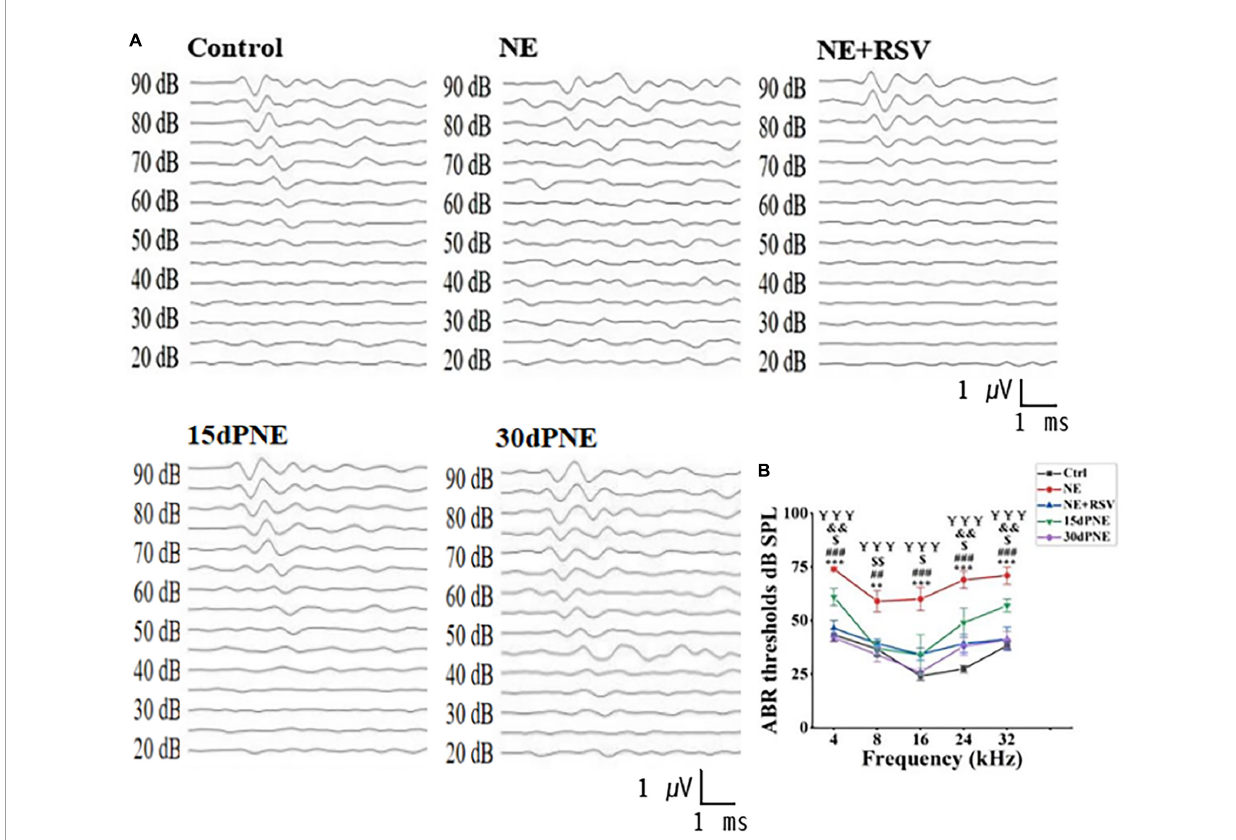
FIGURE2 ABR tests show that noise exposure increased reversibly hearing thresholds, and resveratrol treatment prevented hearing thresholds. (A) Example waveforms from a control mouse (Ctrl), noise exposure mouse (NE), resveratrol treatment mouse (NE + RSV), a mouse 15 days after noise exposure (15dPNE), and a mouse 30 days following noise exposure (30dPNE). (B) The averaged hearing threshold of each group is shown. Compared with the Ctrl group, the hearing threshold of mice in the NE group was significantly increased; the hearing threshold of mice in the NE + RSV group was significantly lower than that of the NE group; improved hearing thresholds were observed in 15dPNE and 30dPNE groups. Values are mean ± SE, data was analyzed by Tukey’s test following one-way of ANOVA. Each group consisted of 7 mice. Statistical difference is represented as * p < 0.05, ** p < 0.01, and *** p < 0.001 for comparisons between the control group and NE group; # p < 0.05, ## p < 0.01, and ### p < 0.001 for the NE + RSV group compared with NE group; $ p < 0.05, $$ p < 0.01, and $$$ p < 0.001 for comparisons between the NE group and 15dPNE group; & p < 0.05, && p < 0.01, and &&& p < 0.001 for comparisons between the Ctrl group and 15dPNE group; ¥ p < 0.05, ¥¥ p < 0.01, and ¥¥¥ p < 0.001 for comparisons between the NE group and 30dPNE